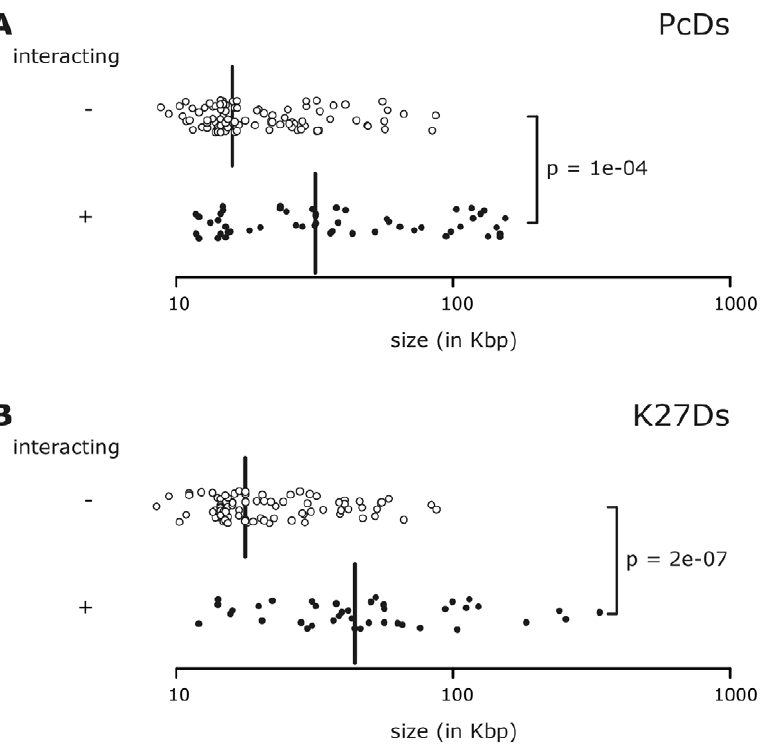
Figure 5. Large PcDs interact more often than small PcDs. (A) Strip charts show size differences between PcDs that interact with at least one of the 4 PcG baits (closed circles) and PcDs that do not interact (open circles). (B) Similar to a, but now for K27Ds. The x-axes indicate domain size in Kbp (log 10 scale), and each dot represents a single domain on chromosome 3. Perpendicular bars are median values and p-values were calculated using a two-sided non-parametric Mann-Whitney U